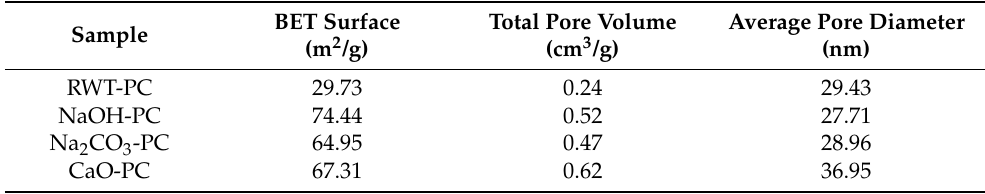
Figure 5. Pore distribution characterization of pyrolytic char (PC) derived from waste tires. Table 3. Structural parameters of pyrolytic char (PC) derived from waste